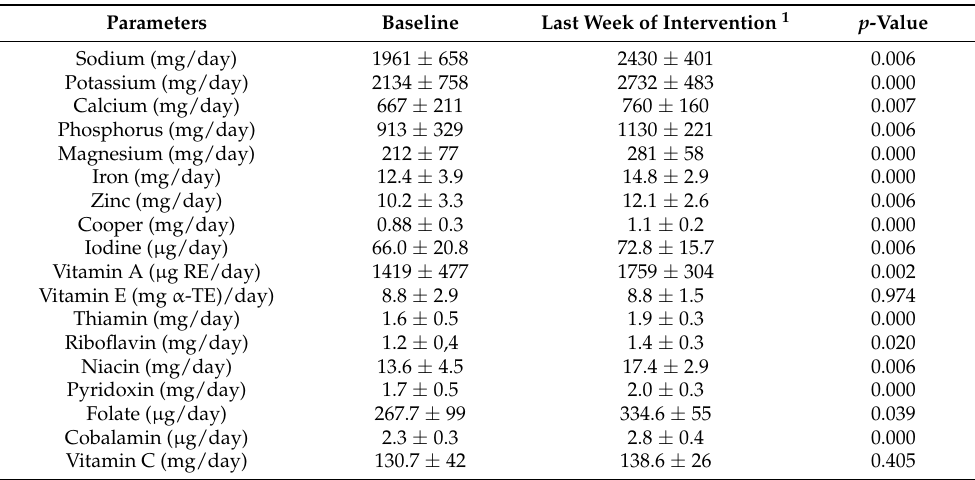
Table 8. Micronutrient intake at baseline and after dietary intervention among study participants ( n = 29).